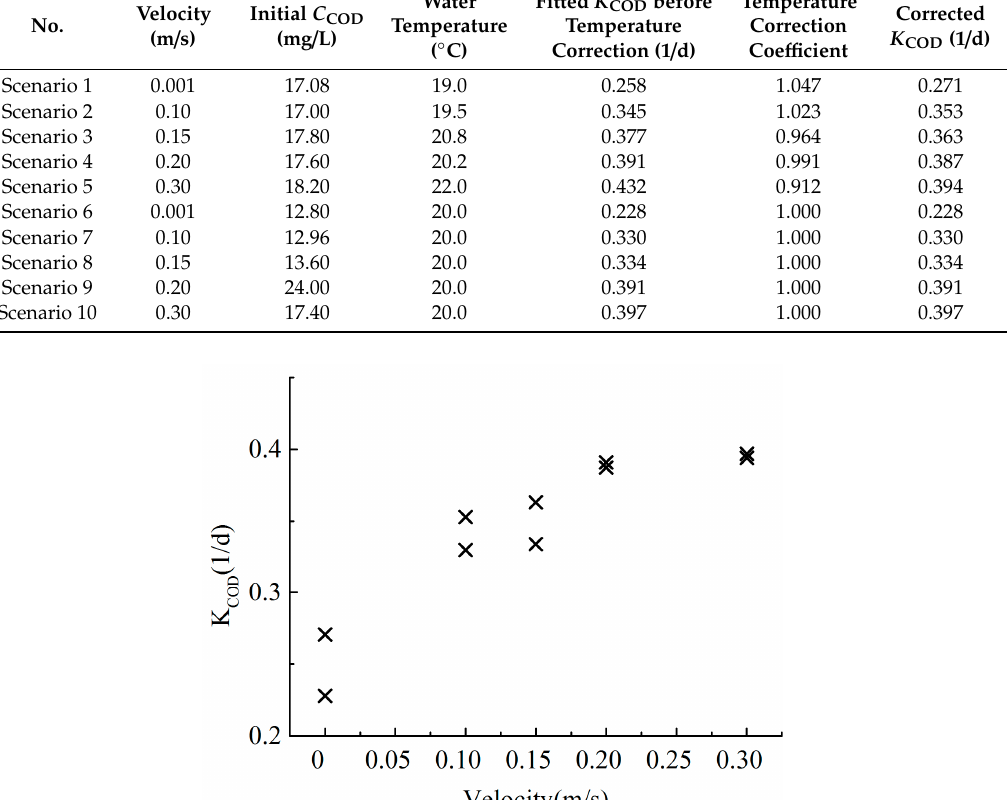
Table 2. Fitting results of K COD under di ff erent hydrodynamic conditions.